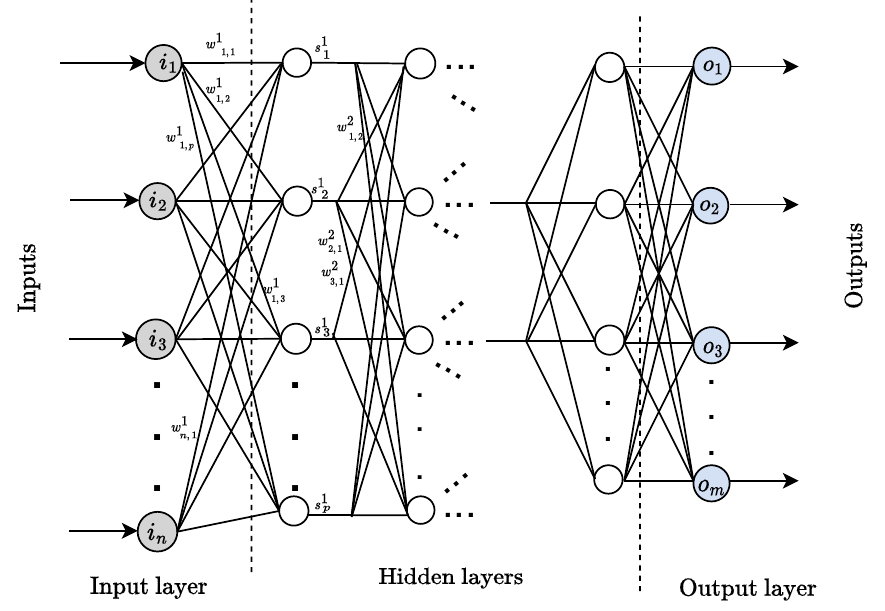
Figure 3. Illustration of a multi-layer perceptron. Information flows from inputs to outputs through connections between unit i and unit j denoted as w 1 propagated towards the outputs o m of the network. Hidden layers may differ in the number of